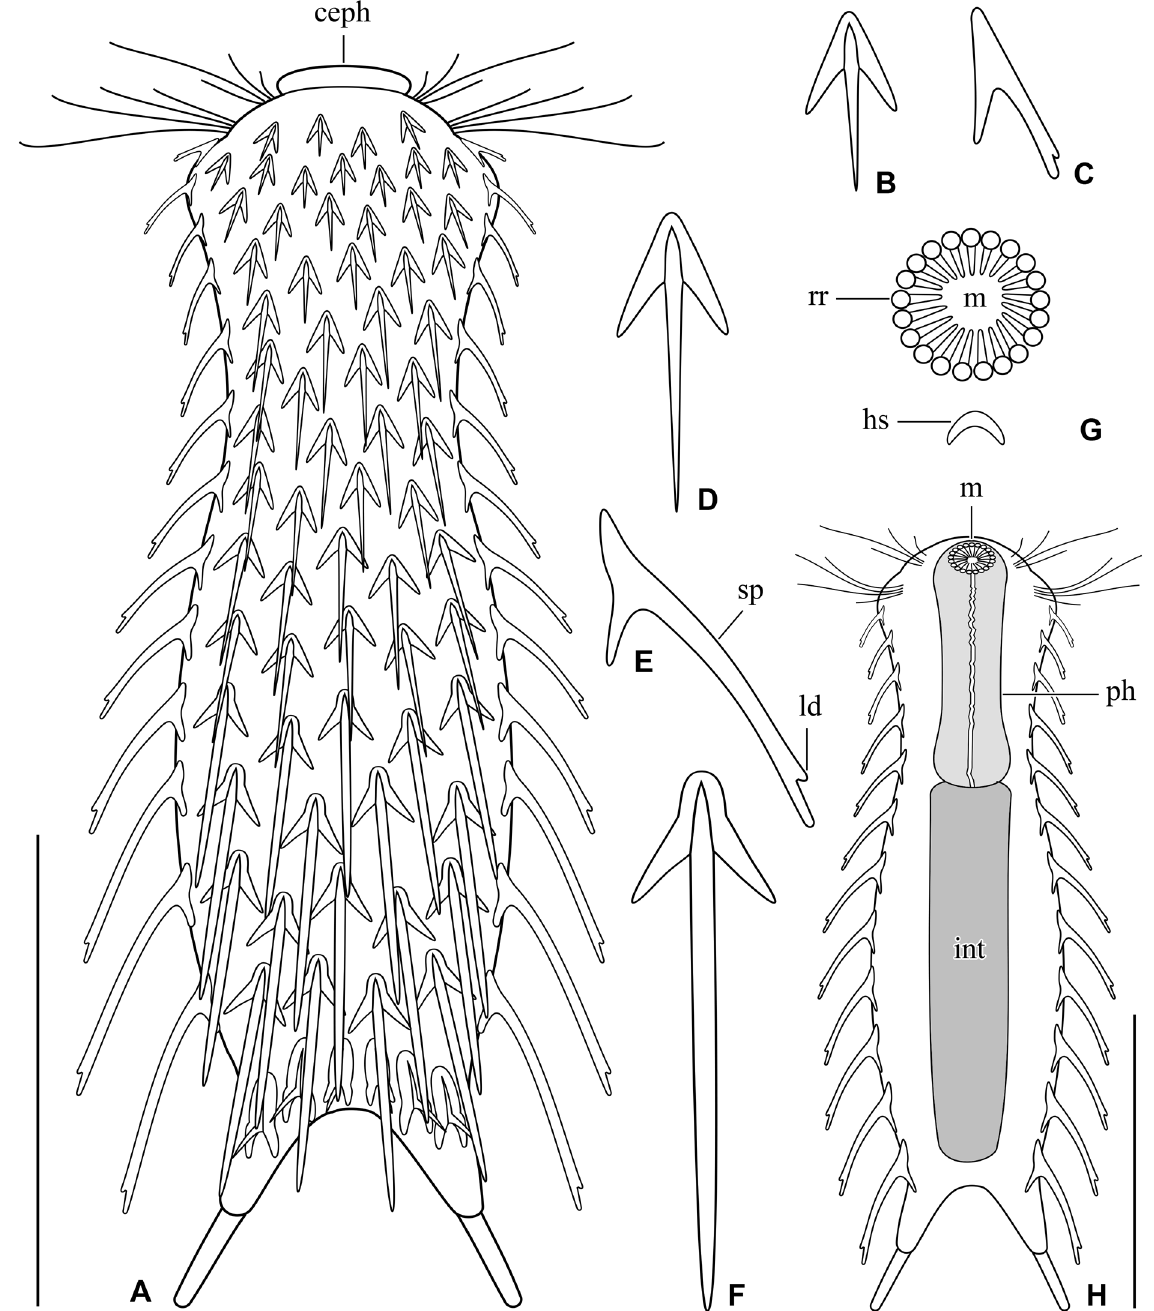
Fig. 37. Chaetonotus ( Hystricochaetonotus ) arcanus sp. nov. A . Dorsal overview showing the scale and spine pattern. B – C . Dorsal and lateral views of a head scale. D . Dorsal view of a neck scale. E – F . Lateral and dorsal views of a trunk scale. G . Detail showing the mouth region. H . Internal morphology. Scale bars = 30